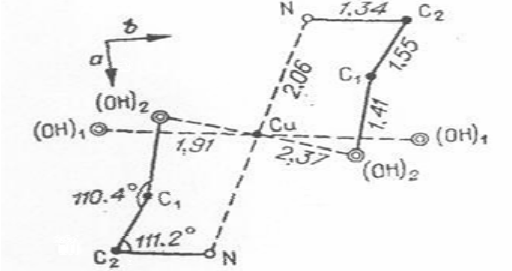
Figure 2. Projection of the molecule on the 001